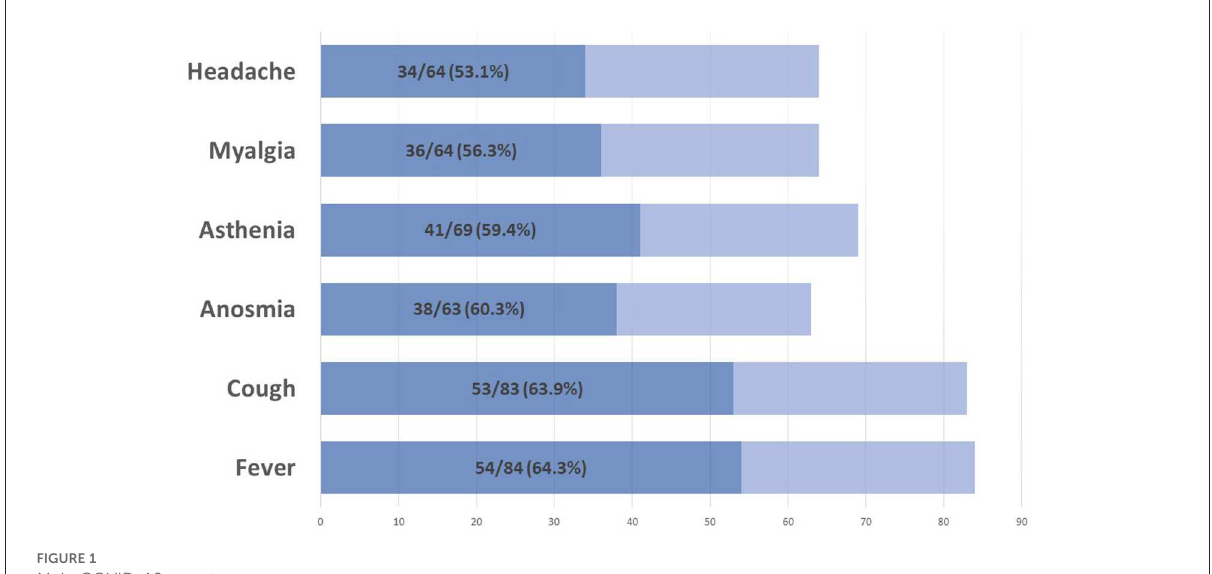
FIGURE1 Main COVID-19 symptoms.